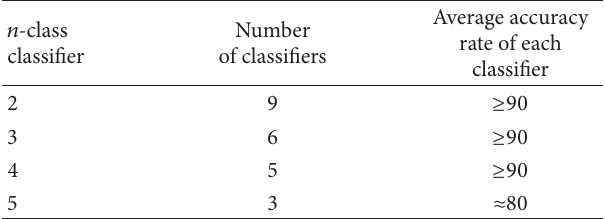
Table 2: A preliminary investigation of 𝑛 selection. 𝑛 -class